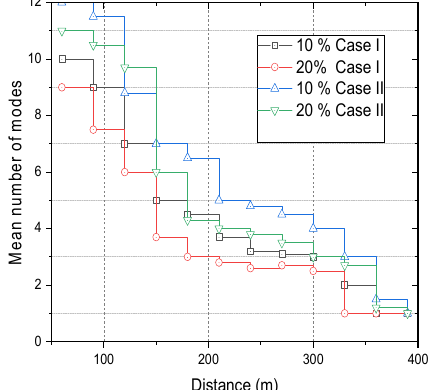
Fig. 3. Mean number of modes in CANMET for Case I and Case